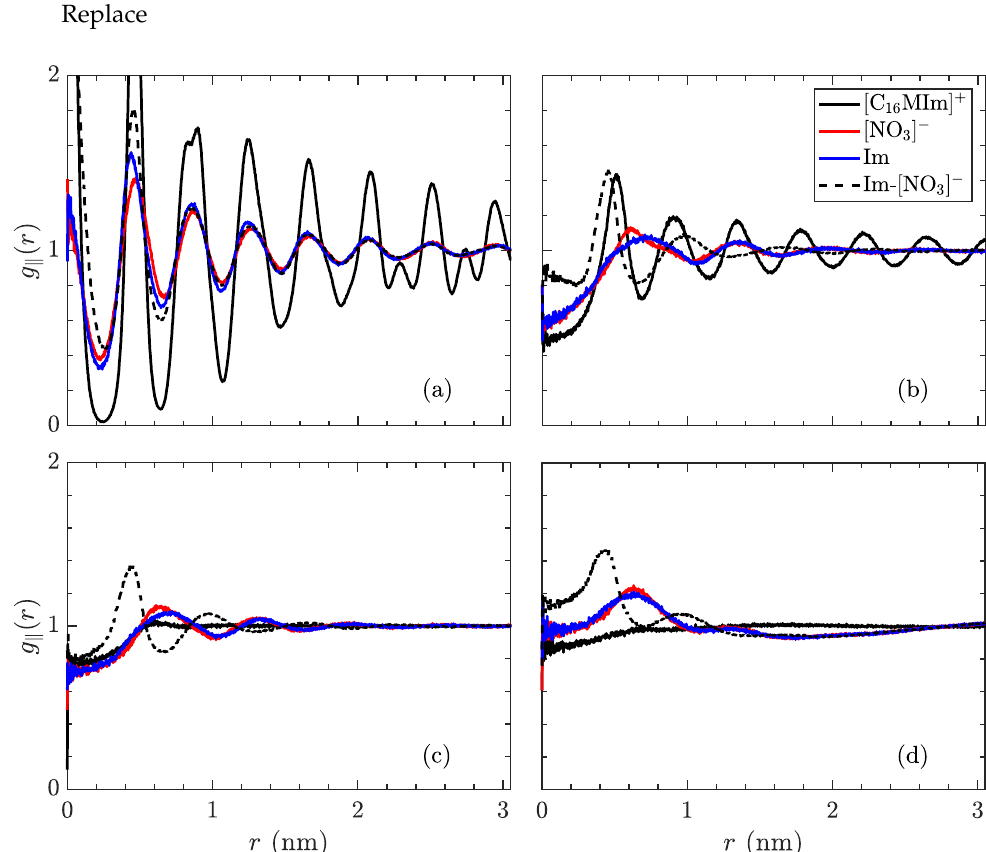
Figure 8. In-plane radial distribution function, g (cid:107) ( r ) of the species in [C 16 MIm][NO 3 ], trajectory- averaged over the last 200ns, at temperatures of ( a ) 300K in the crystalline state, ( b ) 400K just before the transition to the smectic-A state, ( c ) 425K in the smectic-A phase, and ( d ) 600K isotropic liquid. The solid lines signify distribution of a species relative to its own type (black: [C 16 MIm] + , red: [NO 3 ] – , blue: imidazolyl ring) while the dotted line denotes placement of [NO 3 ] – ions in relation to imidazolyl rings. The first phase transition is characterized by the alkyl tails losing almost all order within the xy -plane. The phase transition to the isotropic liquid loses almost all structure, except for pairing of the opposite